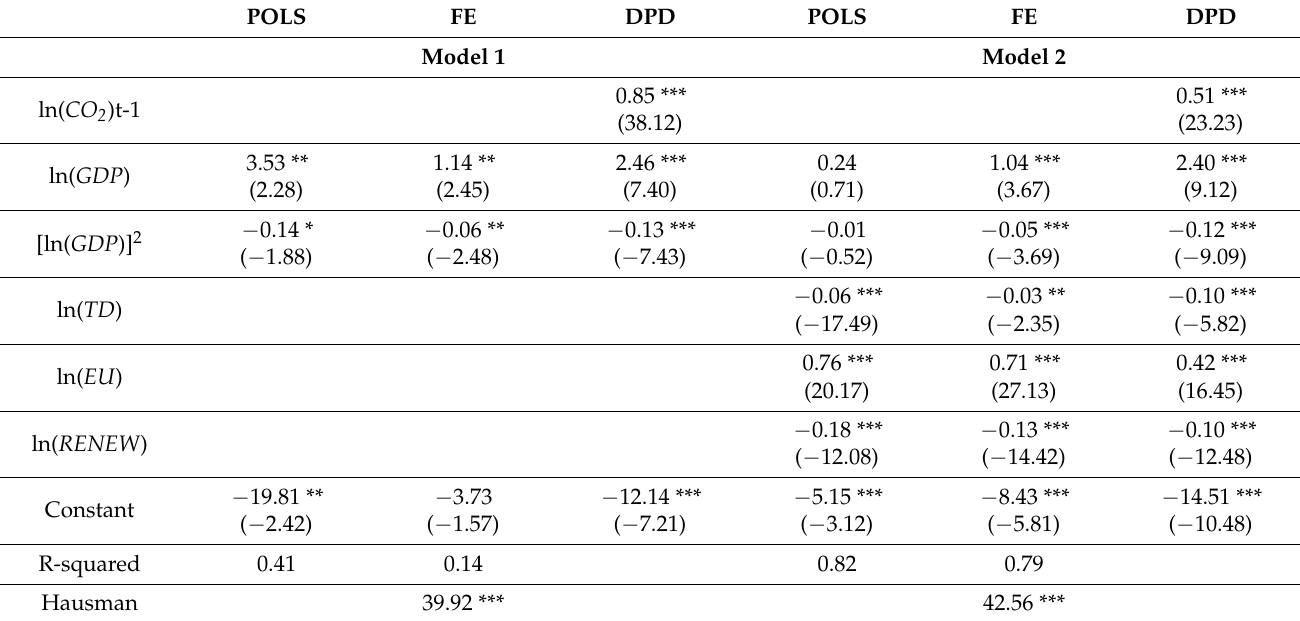
Table 4. The effect of economic growth on CO 2